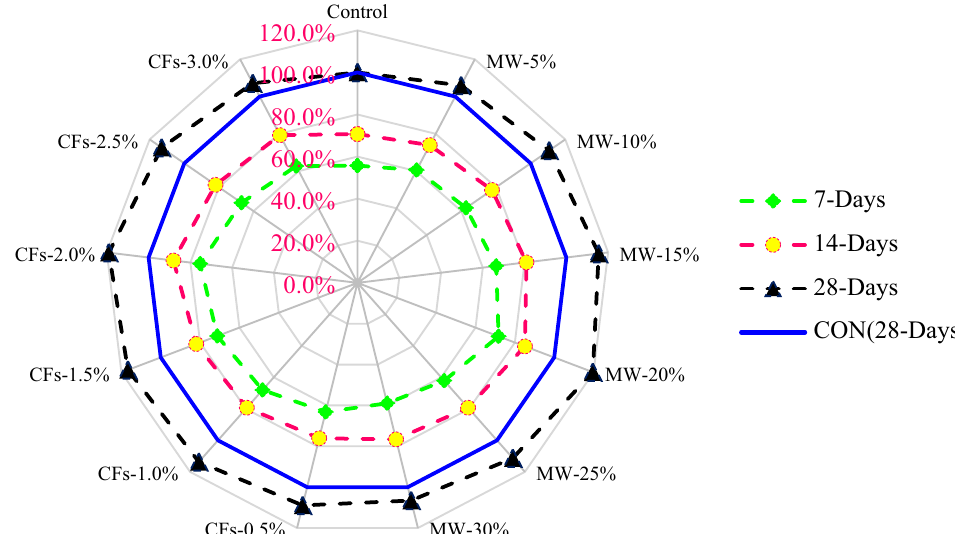
Figure 25. Relative analysis of pull out/bond strength results.